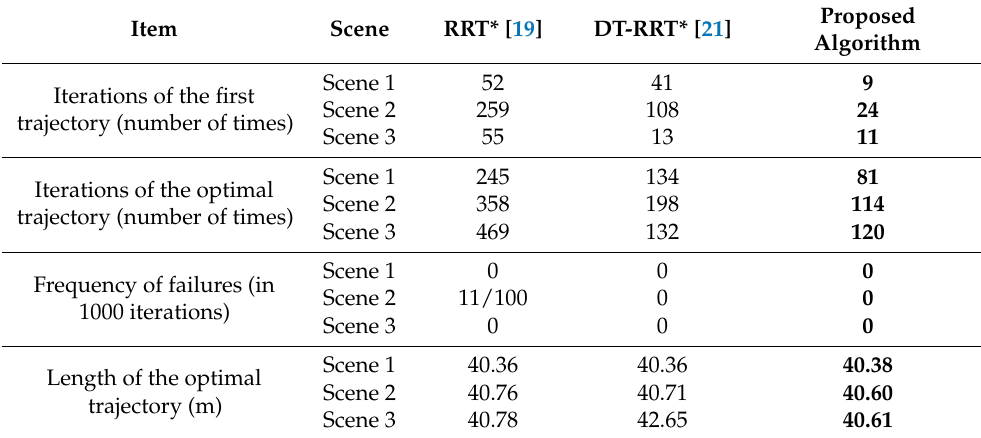
Table 8. The sampling efficiency analysis results of the three